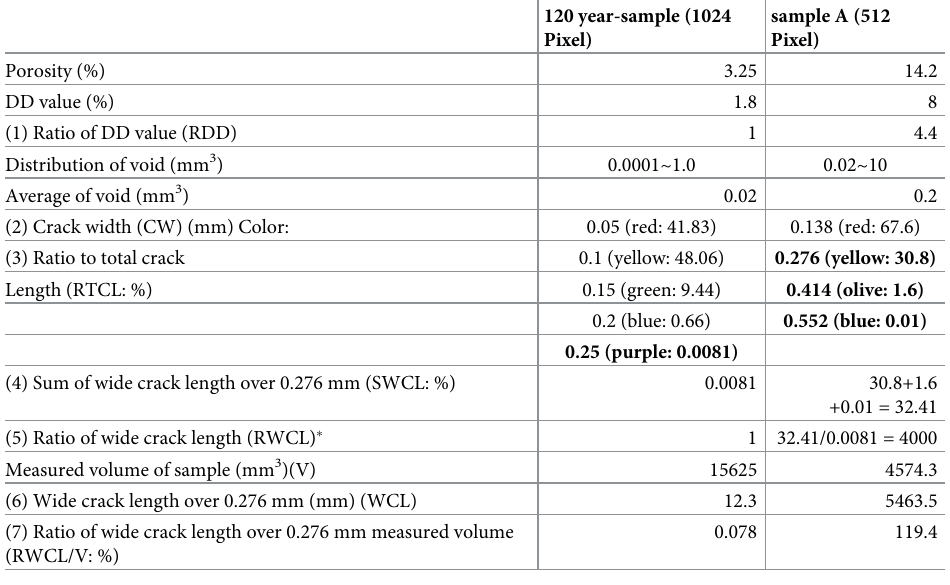
Table 2. Properties of 120 year-sample and new mortar sample A (30 days after formation).